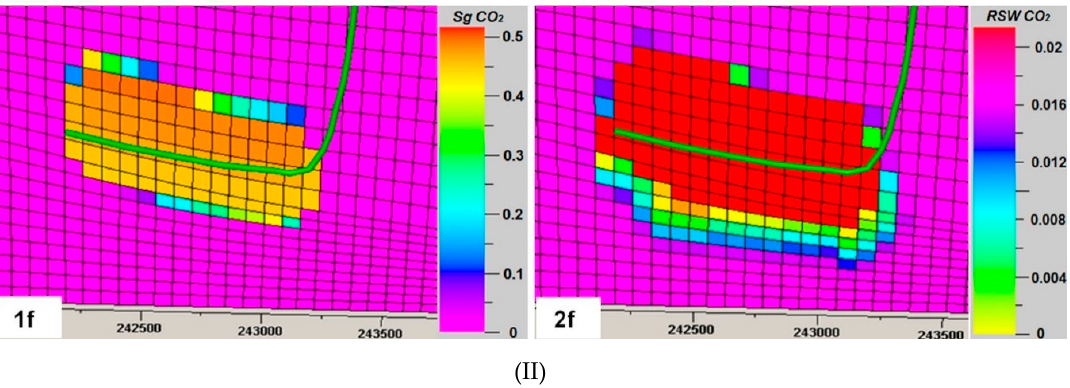
Figure 9. Free CO 2 saturation (1) and distribution of CO 2 dissolved in brine ( RSW CO fraction) ( 2) in the zone of vertical injection wells (variant S7-I and variant S11-II) after ( a ) 5, ( b ) 15, and ( c ) 25 years from the start of injection and after ( d ) 50, ( e ) 200 and ( f ) 400 years after the end of injection.